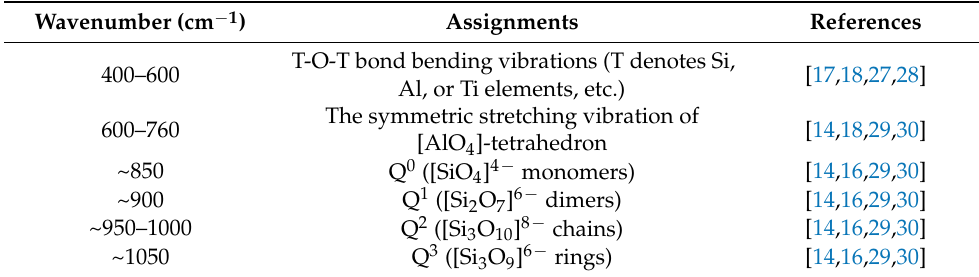
Figure 10. Effect of TiO 2 on the results of FTIR spectra of as-quenched samples. Table 3. Assignments of FTIR spectra bands associated with structural